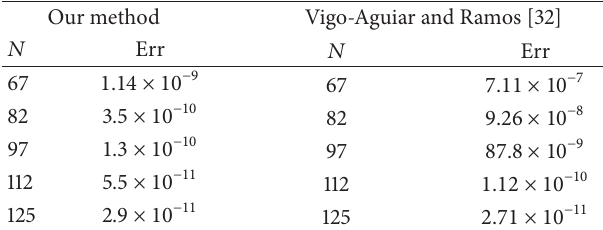
Table 5: Results, with 𝜔 = 1 , for Example 5. Our